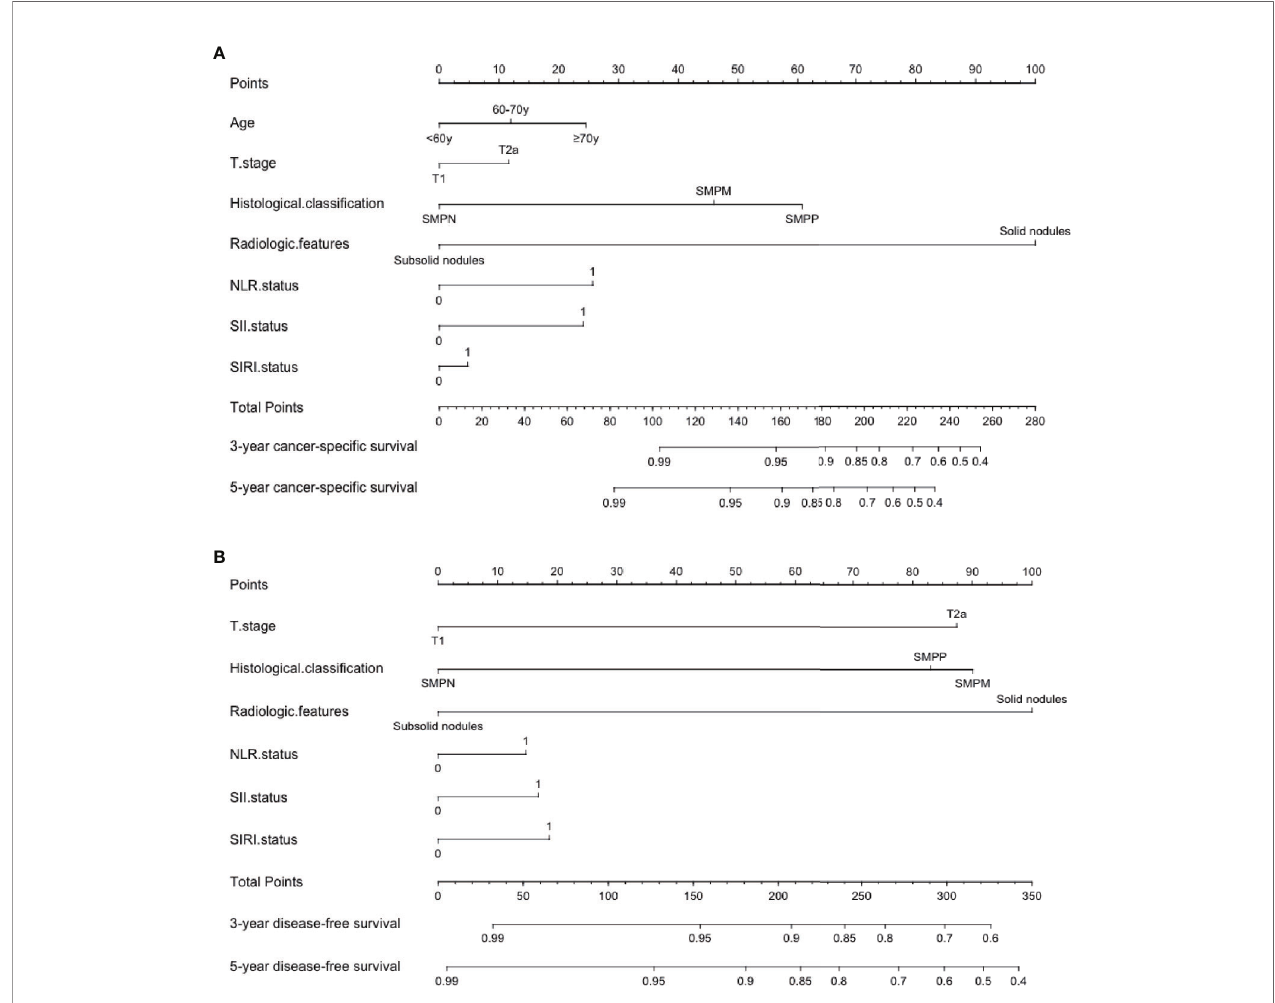
FIGURE 2 | Postoperative prognostic nomogram for predicting (A) 3- and 5-year cancer-speci fi c survival probability (B) 3- and 5-year disease-free survival probability for patients with stage I adenocarcinoma. SMPP, solid/micropapillary-predominant; SMPM, solid/micropapillary-minor; SMPN, solid/micropapillary- negative; NLR, neutrophil-to-lymphocyte ratio; SII, systemic immune-in fl ammation index; SIRI, systemic in fl ammation response